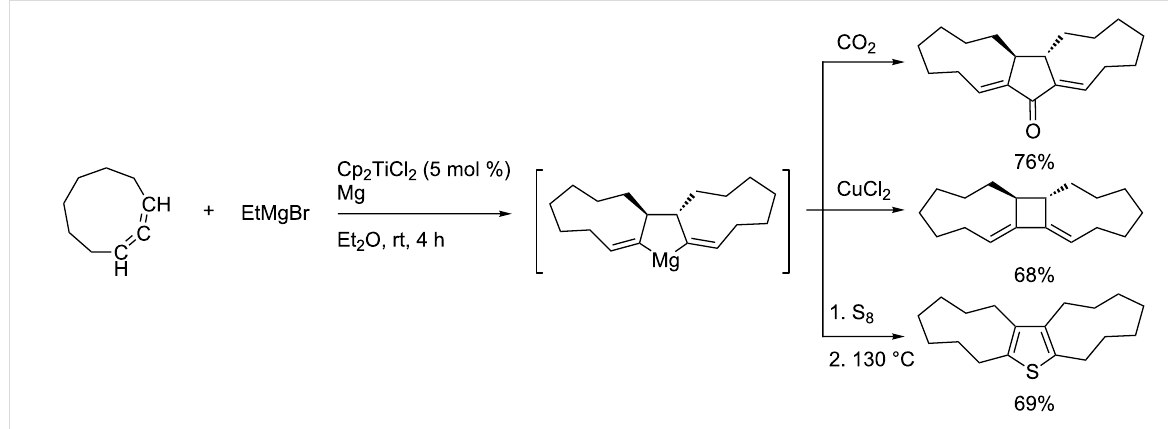
Scheme 52: Synthesis of tricyclic compounds.